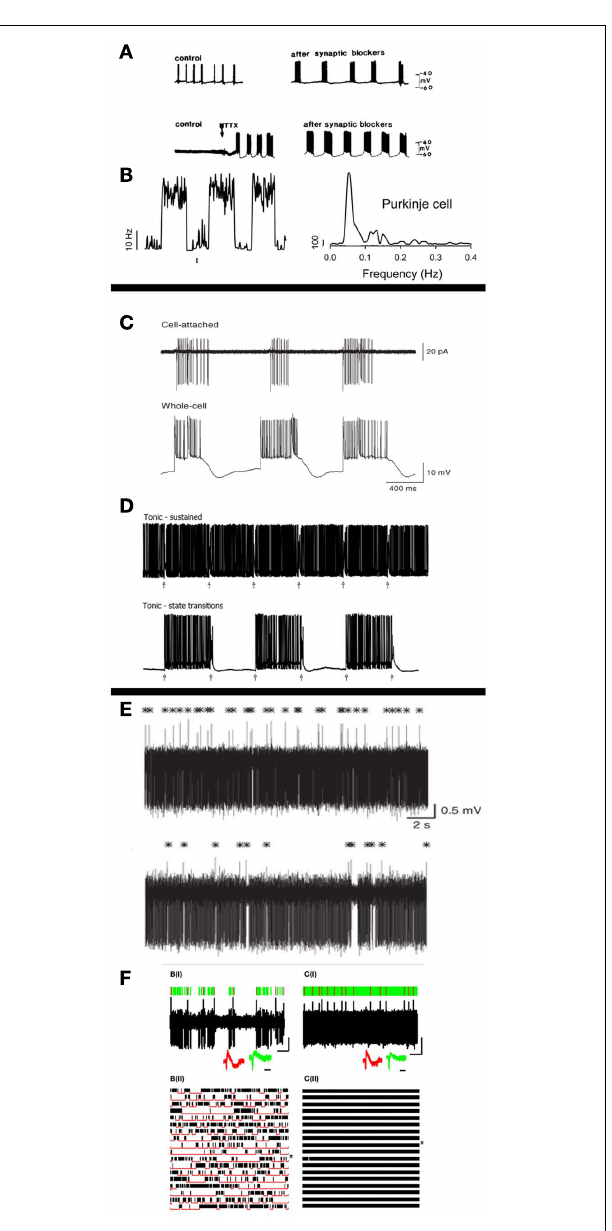
FIGURE 4 | Previous experimental evidence ofAstable, Bistable, and Monostable firing in Purkinje neurons. (A) First description of long period ( < 1Hz) bursting in Purkinje recordings in vitro as being an intrinsic characteristic of these cells. Firing pattern was shown to be unaffected by synaptic blockers (Chang et al., 1993). (B) In vivo demonstrations of low-frequency Astable oscillations in the molecular layer of tottering mice measured using fluorescence (Chen et al., 2009). (C) In vitro demonstrations of Bistability consisting of alternating and near-random periods of low-membrane-potential quiescence and high-membrane-potential rapid firing (Loewenstein et al., 2005). (D) Bistability transitions in vitro via the climbing-fiber input to the Purkinje (arrows), acting as a trigger between states (McKay et al., 2007). (E) In vivo demonstration of Purkinje neurons being primarily in the “up-state,” with occasional pauses (Schonewille et al., 2006). (F) In vivo demonstration of both Bistability (left, with many long pauses) and Monostability (right, with few to none pauses) in Purkinje recordings (Yartsev et al.,